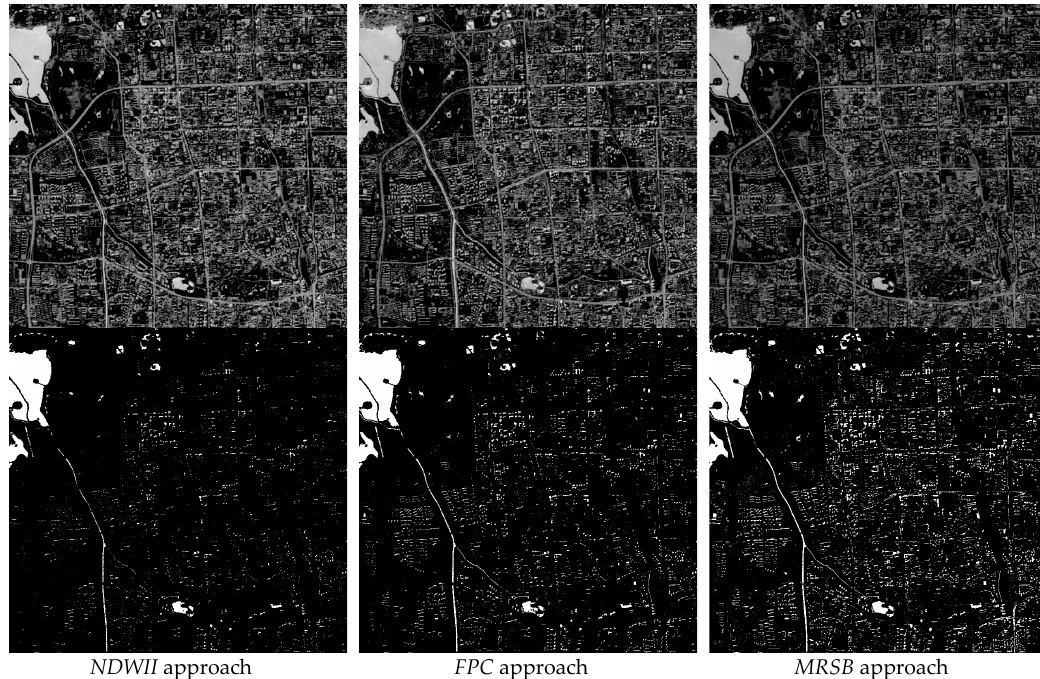
Figure 6. MNDWI images ( upper ) and pixel-wise water extraction ( lower ) at 10 m resolution using three pan-like high spatial resolution bands.